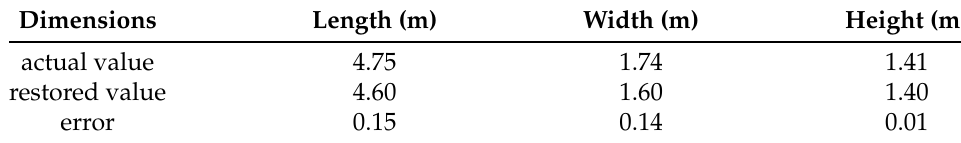
Table 2. Quantitative evaluation of vehicle B.